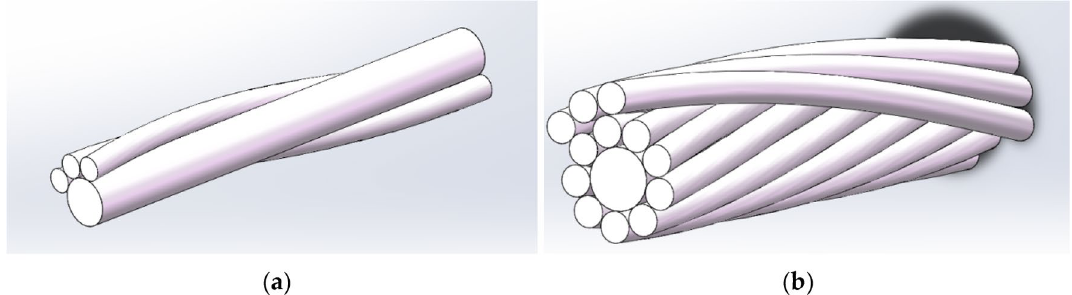
Figure 5. Step-by-step simplified diagram of conductor model ( a ) The same layer strand model; ( b ) Adjacent layer strands